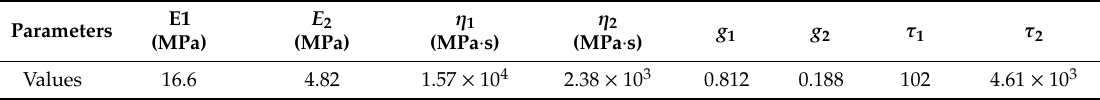
Table 4. Parameter conversion values of the Burgers model for the control.